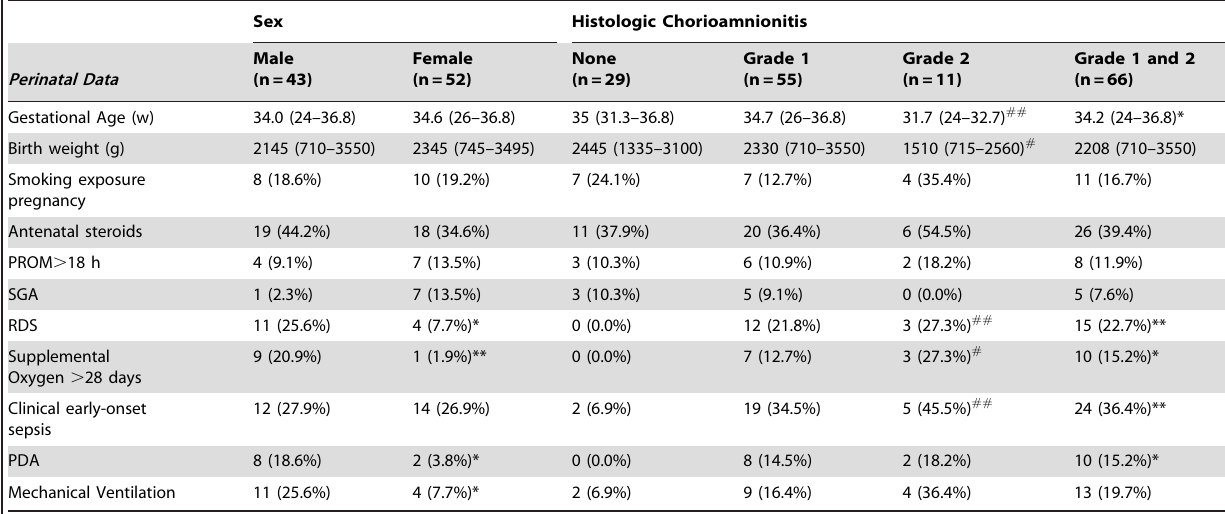
Table 1. Subjects characteristics, stratified by sex and chorioamnionitis.